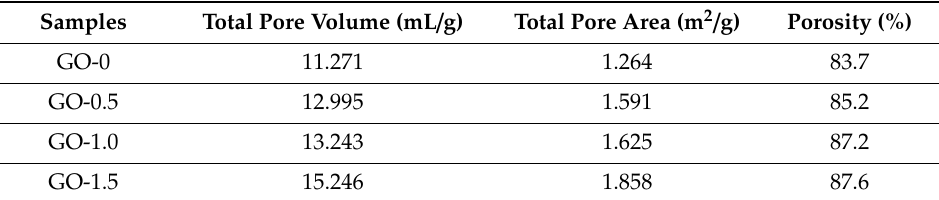
Figure 3. The mercury porosimeter curves of CSAs / GO aerogels. Table 1. The results of the mercury porosimeter.